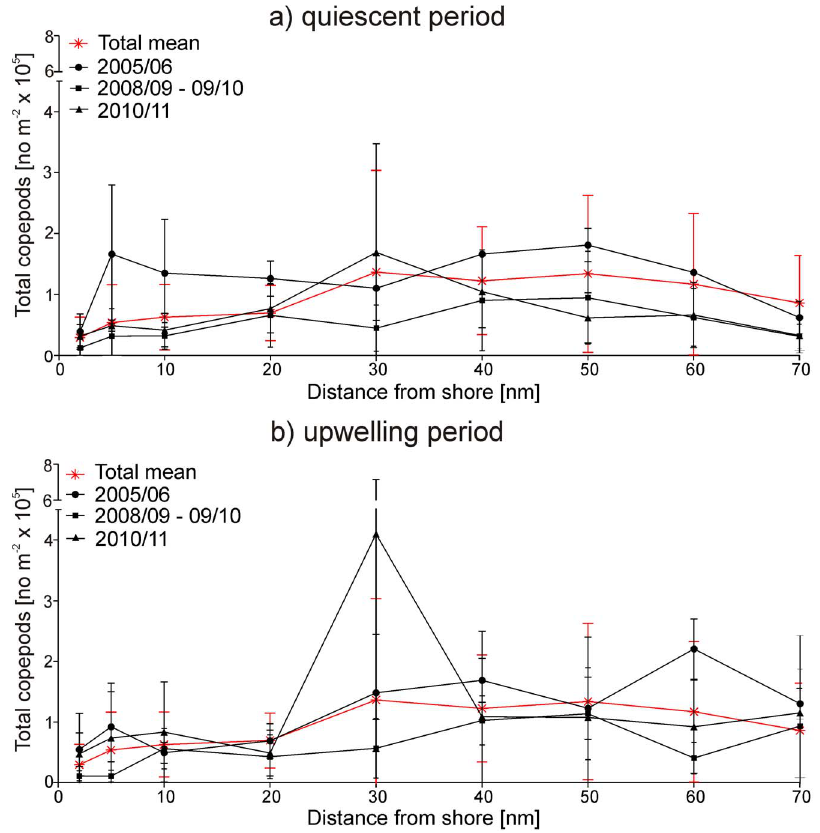
Figure 8. Mean abundance of total copepods ( ± SD) along the transect for upwelling (black) and quiescent (grey) months for the years 2005/06 and 2010/11 with extreme temperature gradients and the years 2008/09 and 2009/10 characterized by weak gradients. The total mean over all years was added (red).